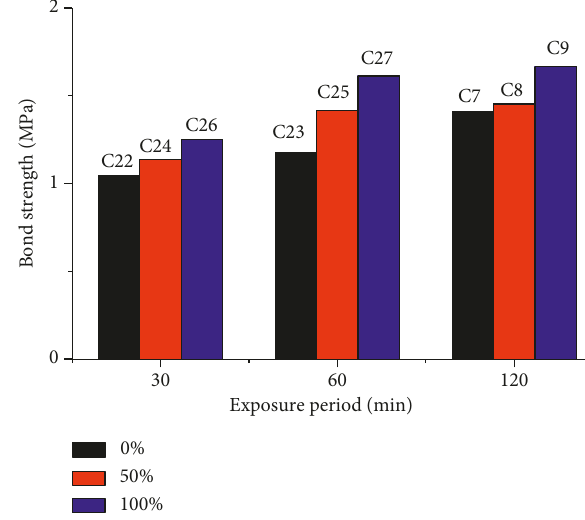
Figure 6: Effect of exposure periods on bond strength. Figure 4: Effect of high temperatures on bond strength.